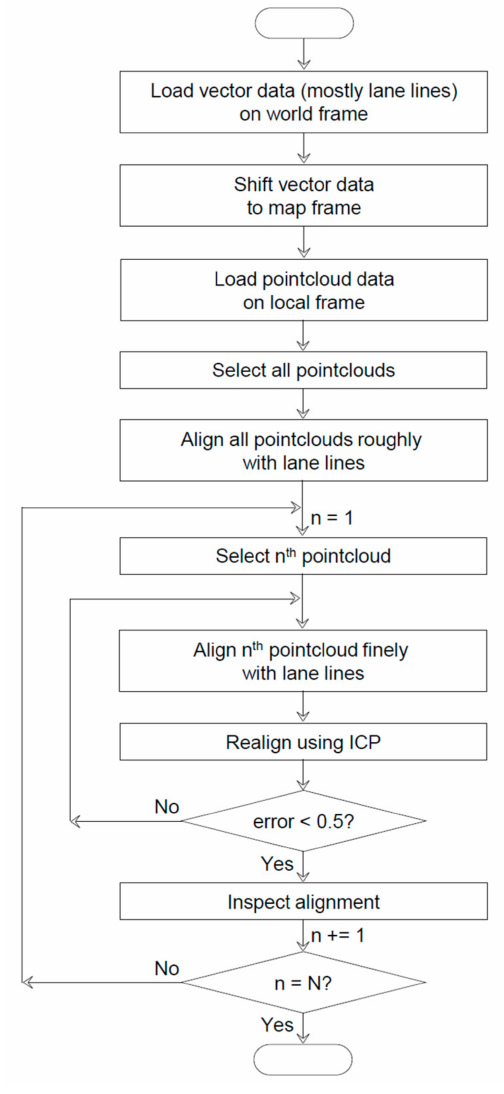
Figure 7. Detailed flowchart of the registration